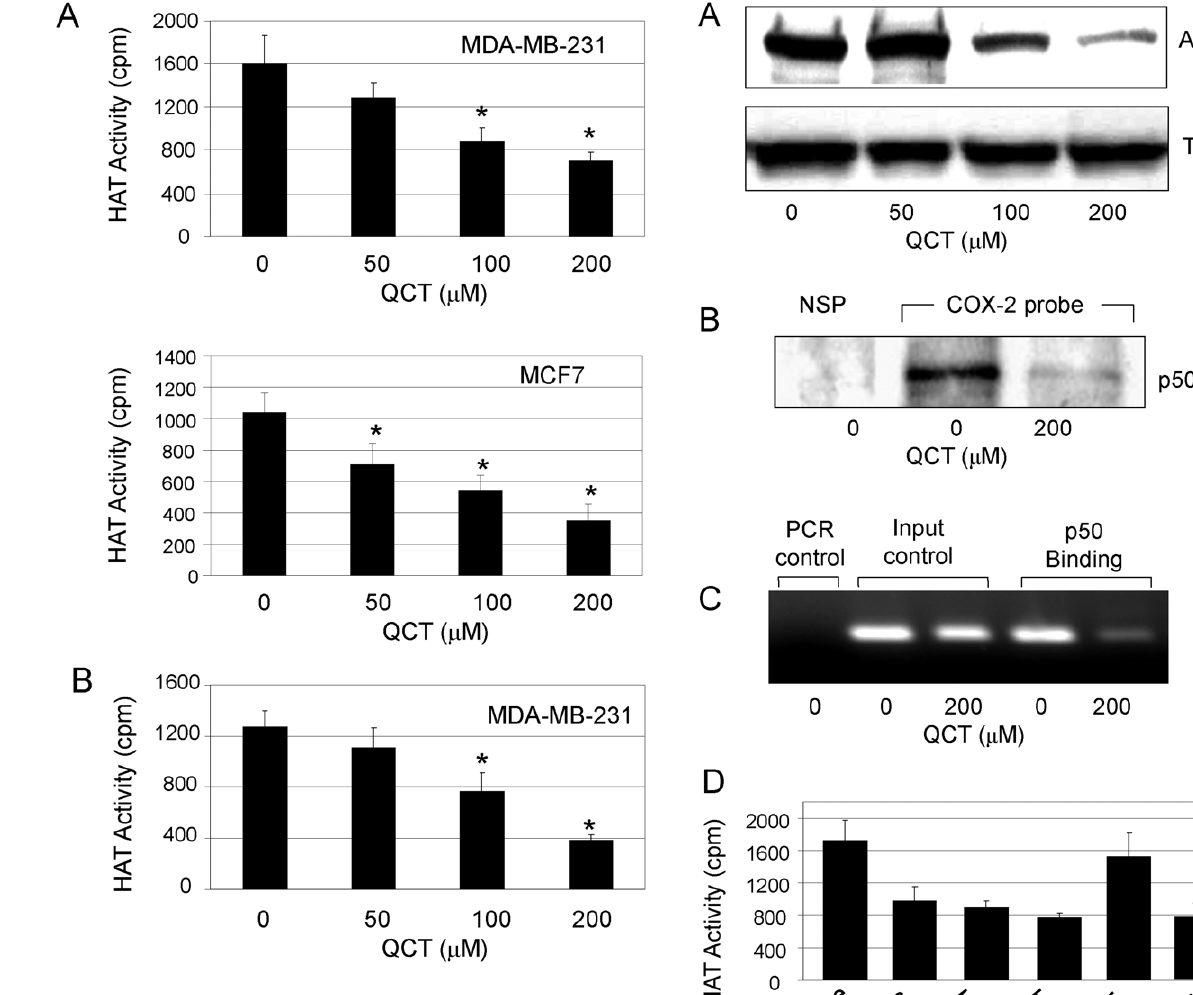
Figure 5. Quercetin suppressed p300 HAT activity. ( A ), Human MDA-MB-231 and MCF7 cells were transfected with FLAG-p300 for 24 h and then treated with quercetin for 24 h. The p300 protein was isolated from nuclear extracts and HAT activity was measured. ( B ), MDA-MB-231 cells were transfected with FLAG-p300. The p300 protein was isolated from nuclear extracts and then treated with quercetin in vitro for 30 min. HAT activity was measured. Each bar represents mean 6 SD of three experiments. *, P , 0.05, significant differences between treatment groups and control groups. doi:10.1371/journal.pone.0022934.g005 breast cell lines (Figure 5B), which is comparable to its inhibition of p300 HAT in vivo (Figure 5A).